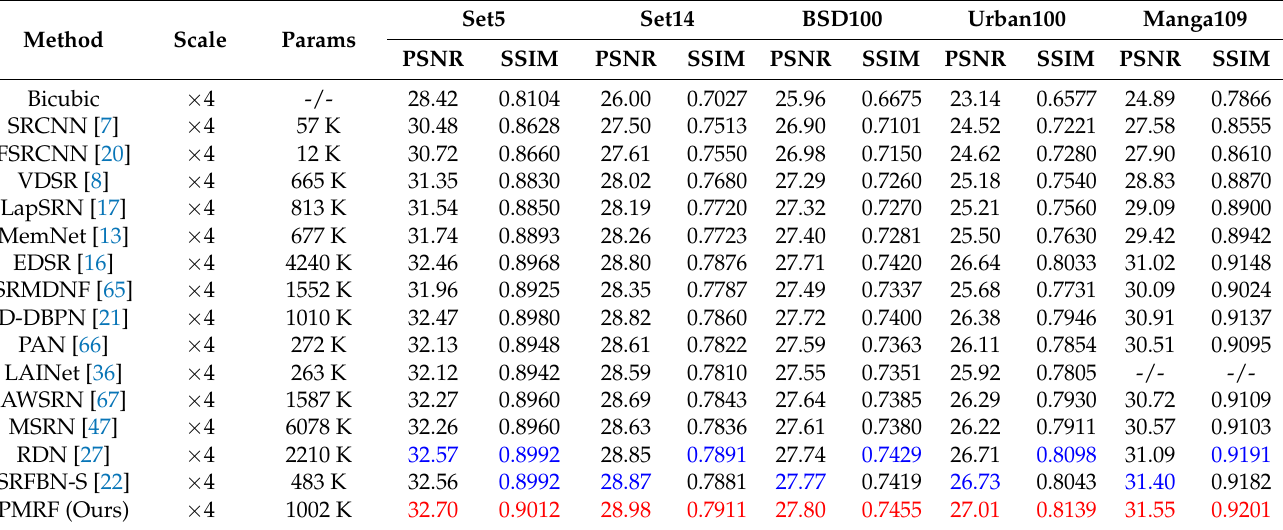
Table 9. Quantitative benchmark test results at × 4 scale. Red indicates the best performance and blue indicates the second